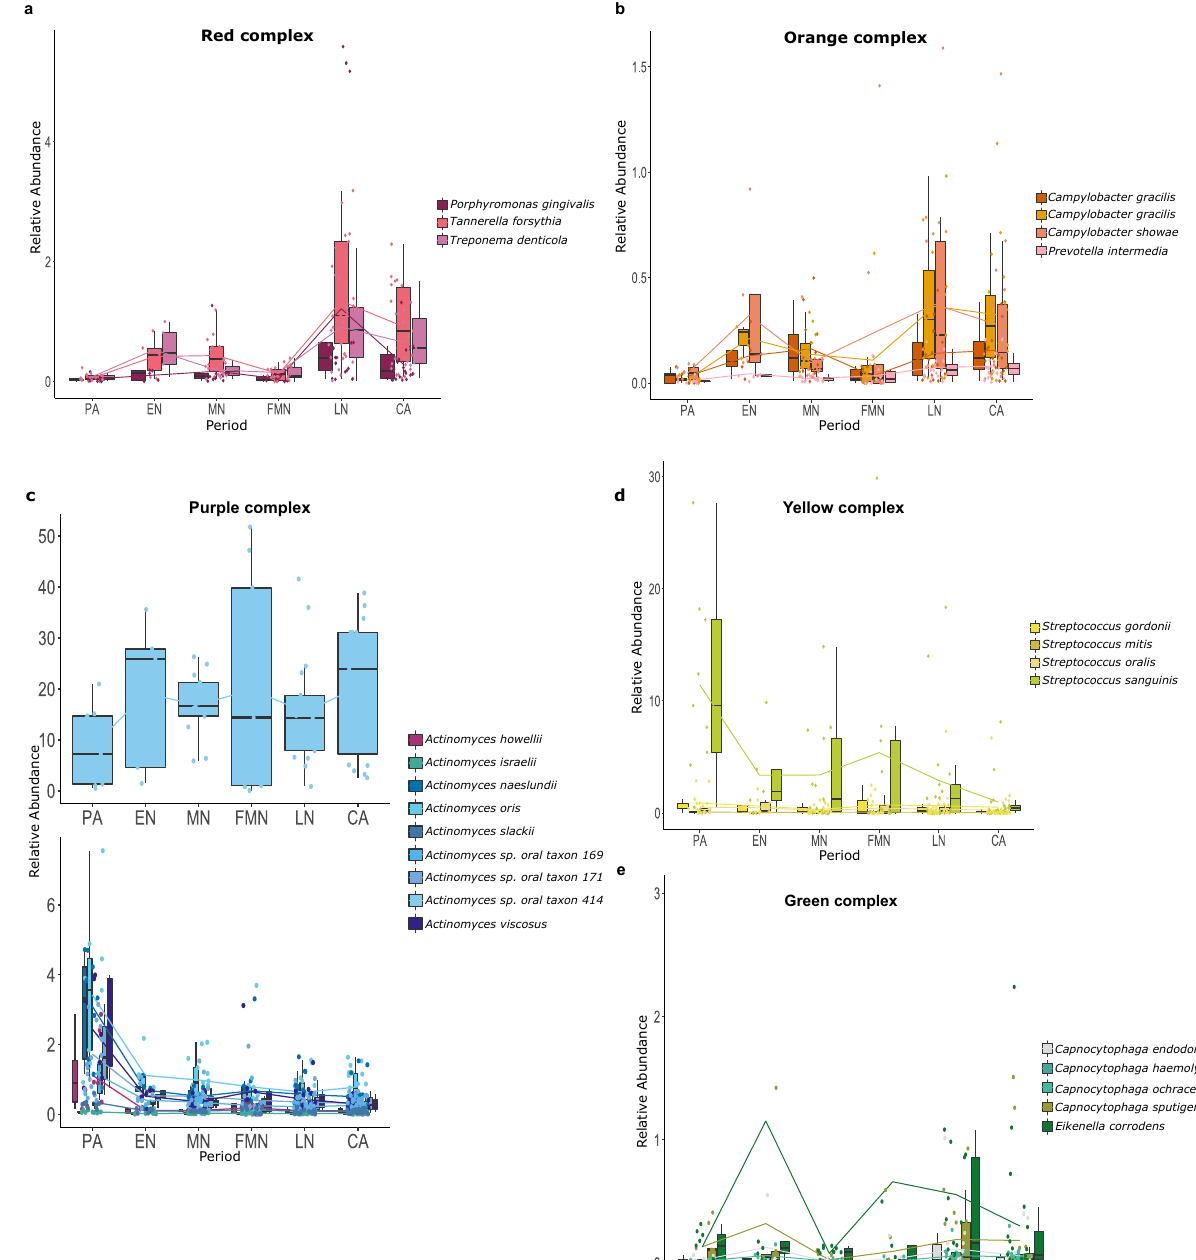
Fig. 3 | Signi fi cant species as identi fi ed from DESEq2 analysis and organised in oral microbiome complexes. a Red complex; b orange complex; c purple com- plex; d yellow complex; e green complex. Others signi fi cant oral species are reportedinSupplementaryFig.10.Samples( n =71)arerepresentedbydotsandare coloured in accordance with species. Boxplots are de fi ned as follow: minimum,